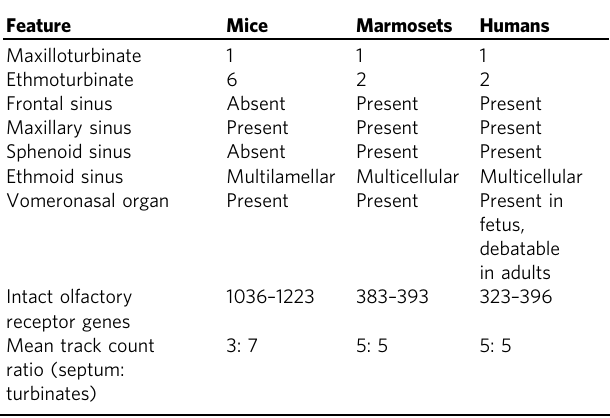
Table 1 Summary of the similarities and differences between mice, marmosets and